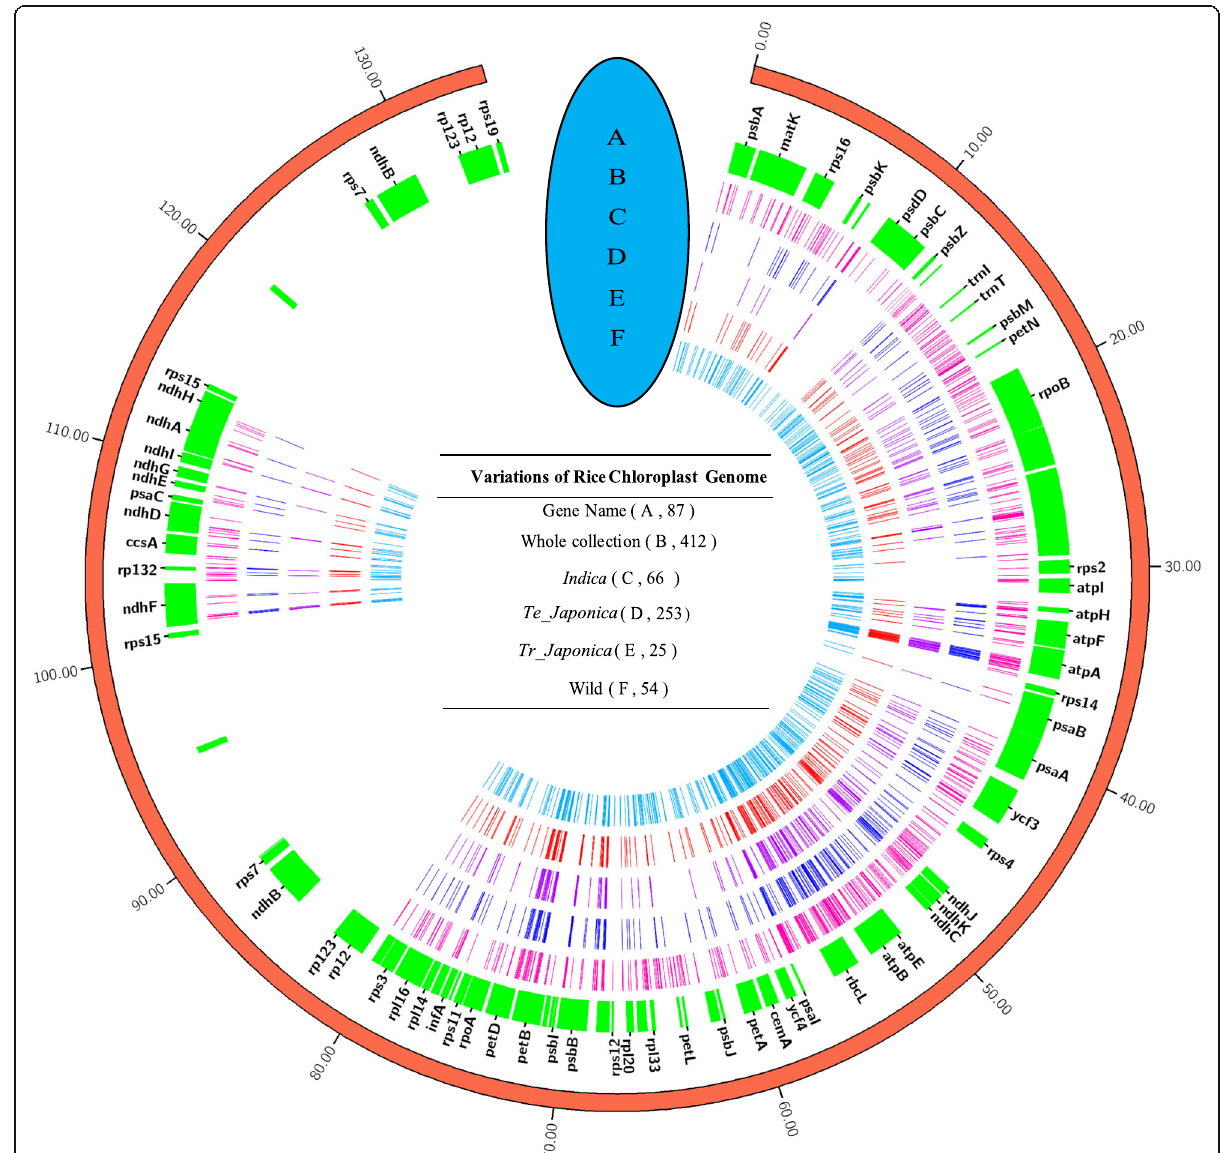
Fig. 2 The band distribution of variant (SNPs and InDels) across the chloroplast genome. The band position is depicted as the distance of the first variant of SNPs or InDels based on the reference genome of Nipponbare . ( a - f ) Highlights marked on the circle map displaying the SNPs and InDels positions. ( a ) The label name of each gene located in the chloroplast genome base on the position of the reference genome. ( b ) Total variants detected among the 412 accessions. ( c ) Variants identified in indica subgroup. ( d ) Variants in temperate japonica type. ( e ) Variants in the tropical japonica type. ( f ) Variants in wild rice. The outside distance unit is kb. The number inside the brackets revealed the number of each accession. In case of the space, not all of the genes were illustrated in the